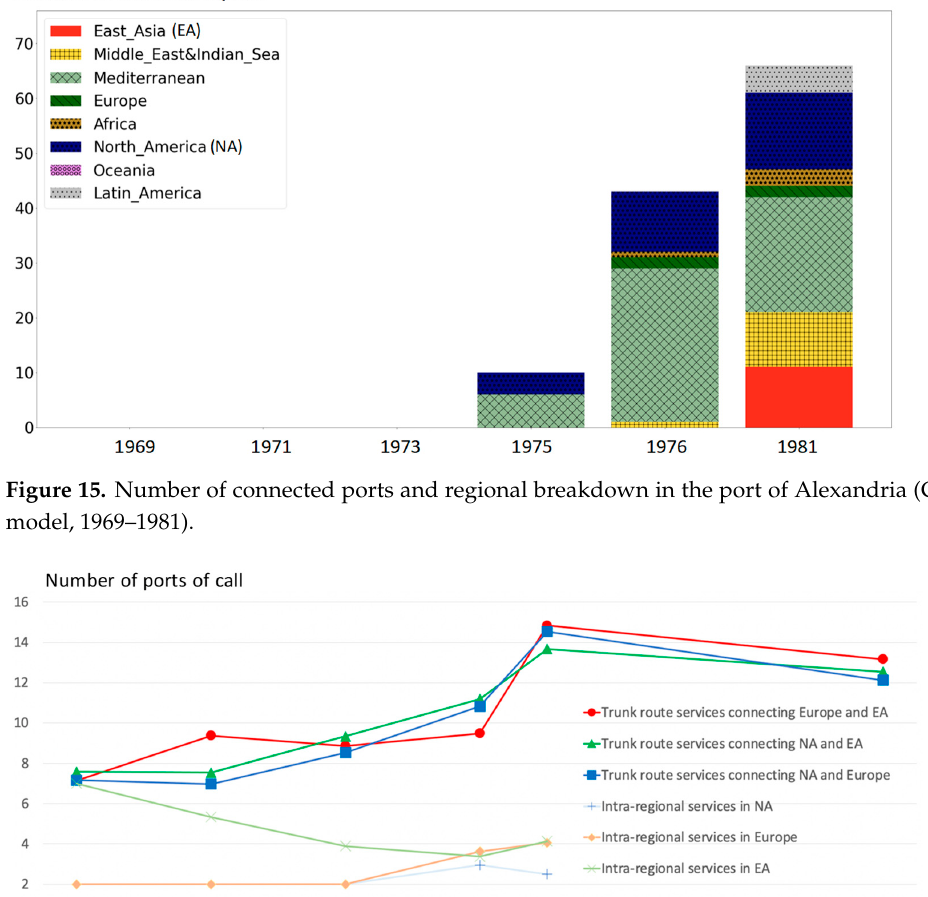
Figure 15. Number of connected ports and regional breakdown in the port of Alexandria (GAL-1 model, 1969–1981).